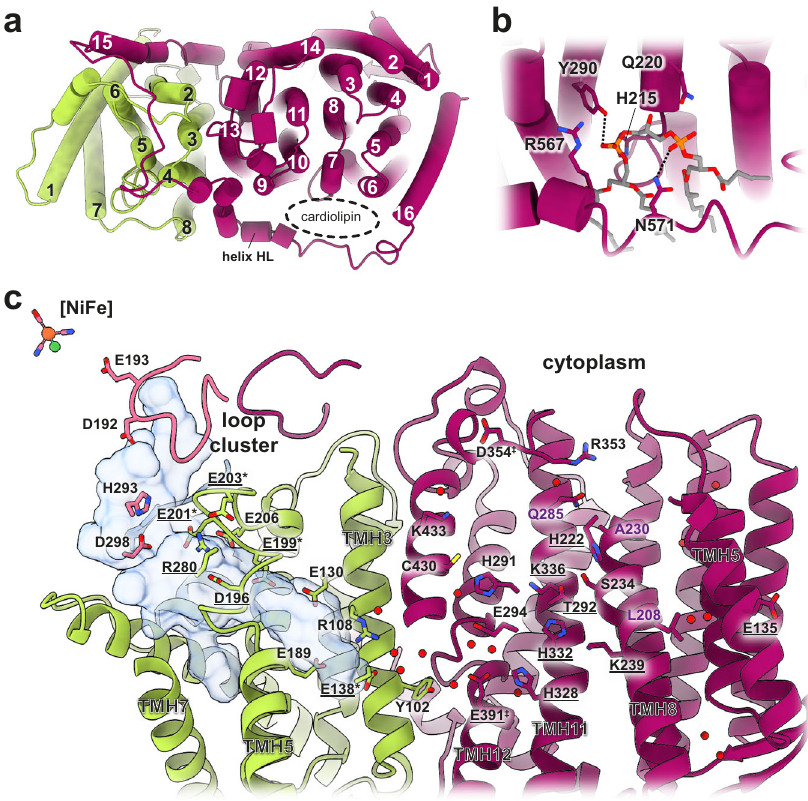
Fig.6|Membranesubunitsandputativesubstrateprotonpathways.a Topview of the FHL membrane arm. HycD contains eight transmembrane helices (TMHs), which are highly tilted. HycC is an antiporter-like subunit consisting of 16 TMHs with a short lateral helix (helix HL) between TMH15 and TMH16. Typical for antiporter-like subunits are the broken helices TMH7 and TMH12. A cardiolipin (CDL) molecule is clamped between the helix HL and the antiporter-like part of HycC. b TheheadgroupofCDLisstabilizedbyArg567,Tyr290,His215,Gln220,and Asn571. Atoms in H-bond distancearemarked withdashed lines. c Detailed view of the FHL membrane arm. HycD harbors a hydrophilic cavity (analyzed with CASTp 3.0 91 usinga1.4Åprobe)thatconnectsthe β 1- β 2loopclosetothe[NiFe]activesite with the membrane. Several hydrophilic residues line the E-channel (HycD Glu201, Glu206, Glu199, Glu130, Glu189, Arg108, Glu138, and Tyr102), residues with con- servationincomplexIareunderlined.Tyr102isabout4Åfromtheadjacent,highly